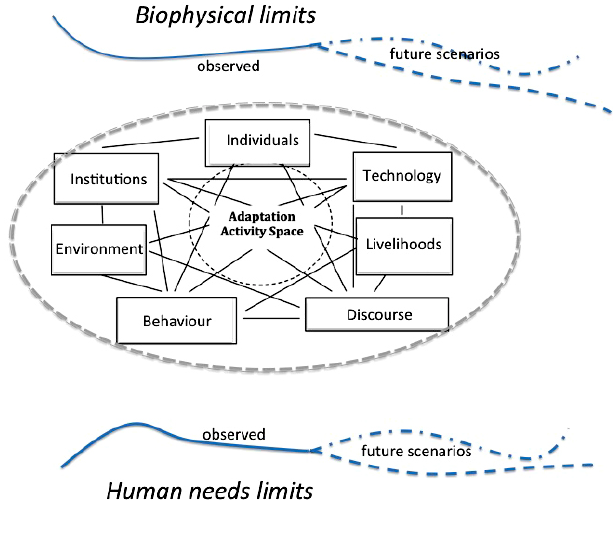
Fig. 1 . Adaptation activity sphere within observed and future scenario